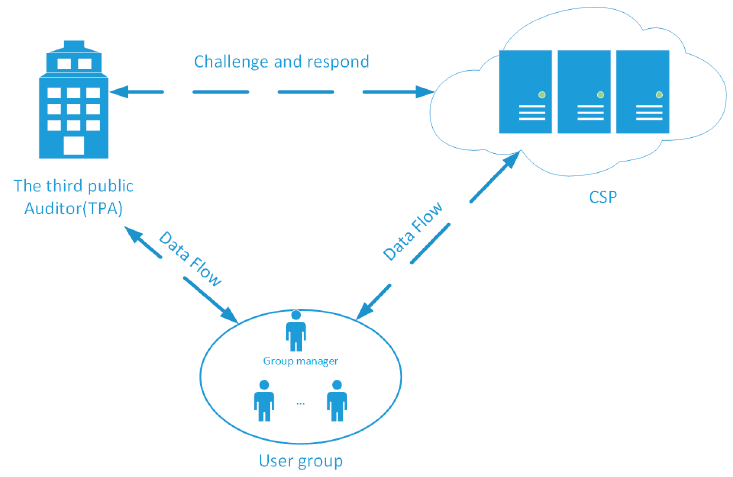
Figure 1. System model of our protocol.